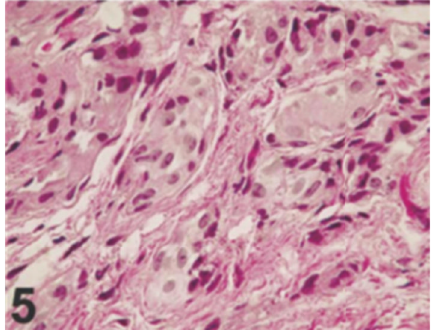
Figure 9: The cytologically bland neoplastic cells are arranged in a diffuse pattern of relatively ill-defined and variably sized nests (Case 2) (hematoxylin-eosin, original magnification × 600) Xiao et al. [28].